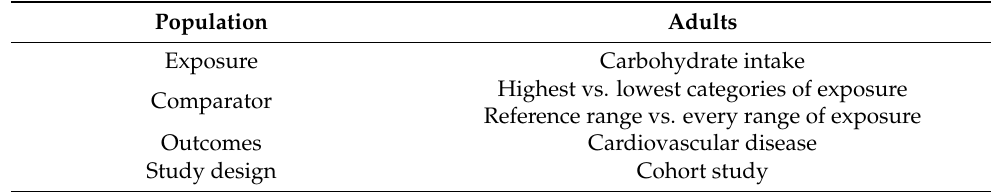
Table 1. PICOS criteria for inclusion and exclusion of